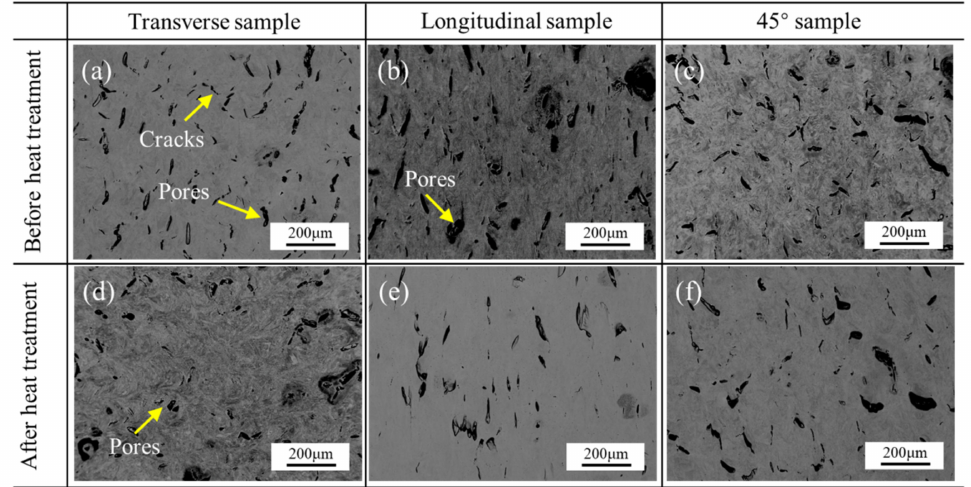
Figure 2. Surface morphologies of SLM GH3536 alloy samples before ( a – c ) and after ( d – f ) heat treatment in different